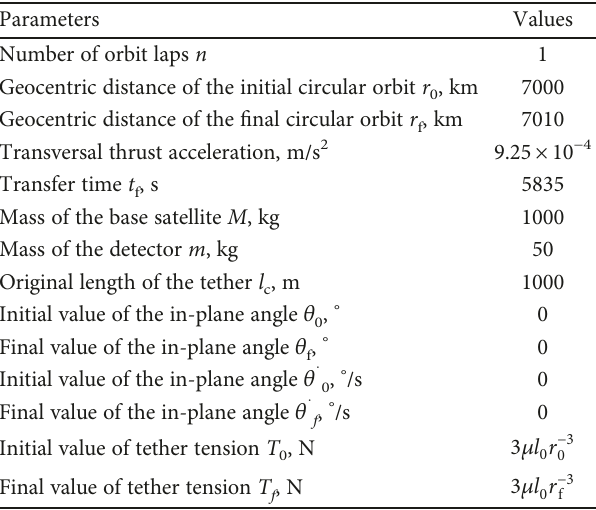
Table 1: System parameters of the tethered system under tension